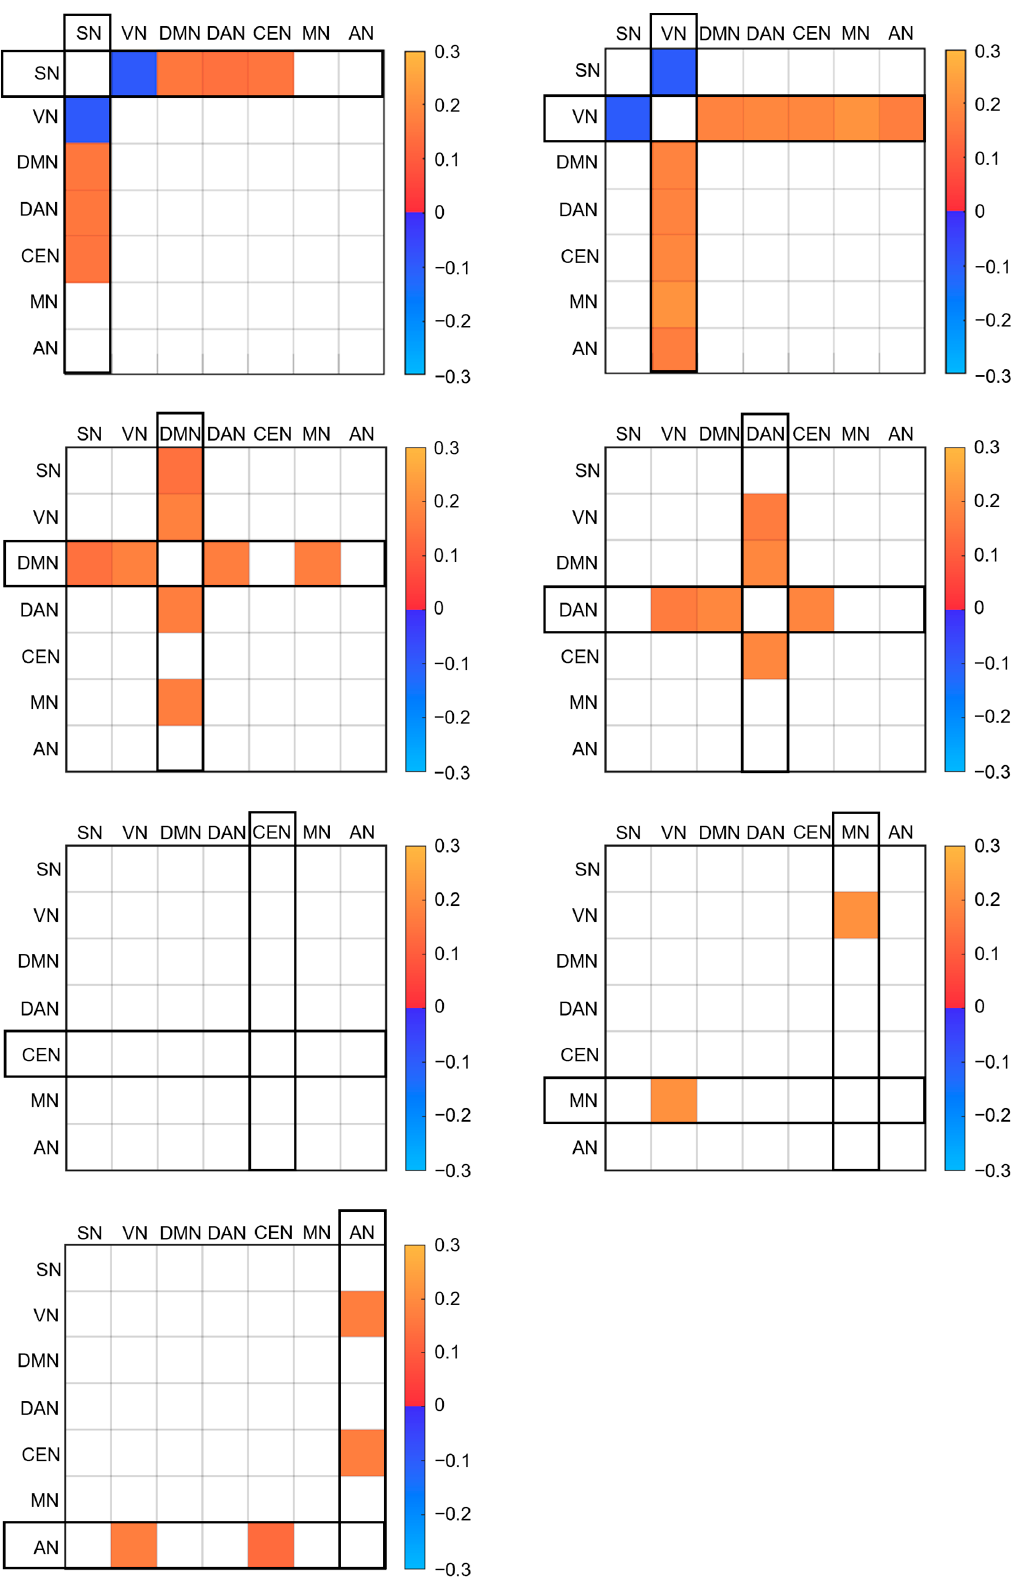
Figure 3. The FC differential patterns (EC–EO) between networks ( p < 0.05, FDR corrected). Red colored boxes indicate higher FC, while blue colored ones indicate lower FC during EC. The black rectangular box indicates which networks we selected for comparison to others within the matrices. The color range represents the inter-network FC difference (Fisher